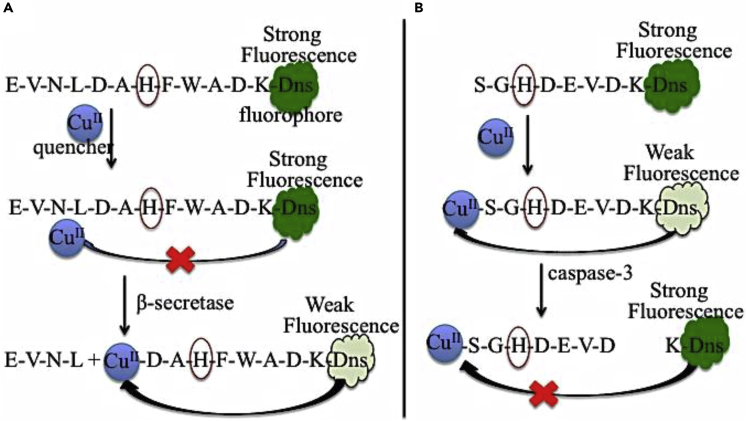
Application of ATCUNs as Fluorescent ReportersFluorescence emission of proteases models, β-secretase (A) and caspase-3 (B) is quenched by CuII-ATCUN. Dns; flurophore. Modified from Deng et al., 2019b.